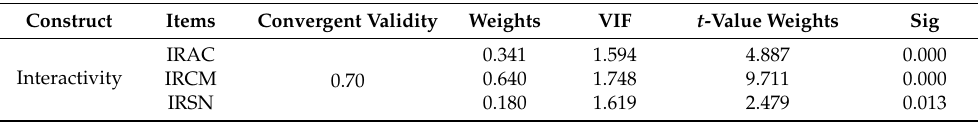
Table 4. Formative Construct’s Properties.